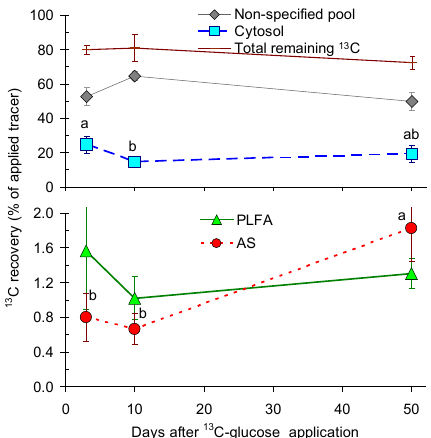
Figure 1. Partitioning of glucose-derived 13 C in SOM presented as the 13 C recovery (% of initially applied 13 C) between the following pools: non-specified SOM (calculated as total 13 C recovery subtract 13 C recovery in cytosol, PLFAs and amino sugars), cytosol, PLFAs and amino sugars. Brown line indicates the total remaining glucose- derived 13 C glucose in the soil and is a sum of 13 C in non-specified SOM, cytosol, PLFAs and amino sugars. Small letters reflect dif- ferences between the sampling points for the distinct pool. Data present mean ( n = 4) and bars present standard errors (SEs). The SEs for the amino sugars are not fully